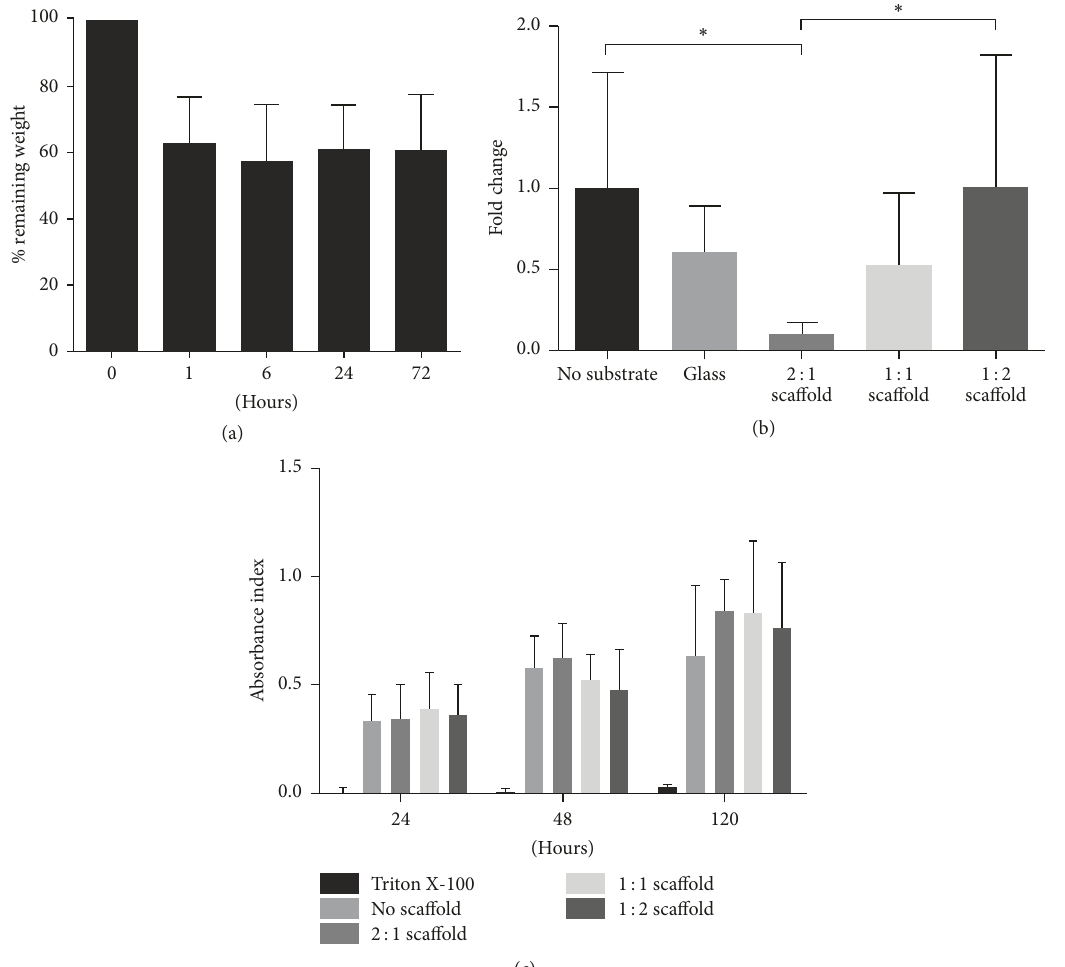
Figure 5: (a) Fiber degradation profile, (b) antibacterial properties of the fibers expressed in fold increase of bacteria, and (c) fibroblast proliferation rate on blend fibers [72] (figure obtained from an open access article distributed under the Creative Commons Attribution License). ∗ indicates statistically significant differences ( ∗ 𝑃 < 0.05